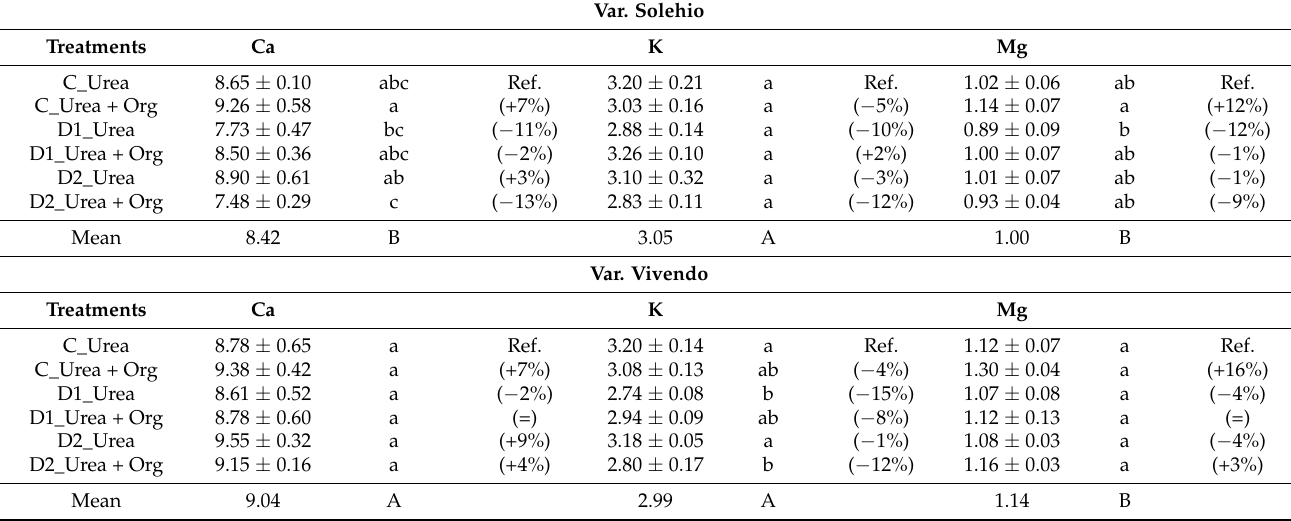
Figure 4. Magnesium concentration (mean ± S.E.; n = 3) in grains and straw at harvest in the varieties Solehio ( A , B ) and Vivendo ( C , D ) following the biofortification treatment with D1 and D2 doses of Ca + Mg + K, applied with urea (Urea) and urea + organic (Urea + Org) nitrogen fertiliser, and in the two controls C_Urea and C_Urea + Org without cations. Letters above histograms indicate significant differences between treatments (Student–Newman–Keuls test; p ≤ 0.05). In brackets: % variation of treatments vs. urea control (C_Urea). Table 4. Straw-to-grain element concentration ratio (mean ± S.E.; n = 3) at harvest in the wheat varieties Solehio and Vivendo following the biofortification treatment with D1 and D2 doses of Ca + Mg + K, applied with urea (Urea) and urea + organic (Urea + Org) nitrogen fertiliser, and in the two controls C_Urea and C_Urea + Org without cations. Small letters indicate significant differences between treatments within the same wheat variety (Student–Newman–Keuls test; p ≤ 0.05). Capital letters: comparisons among varieties within the same element (main effect “Variety”). Var.